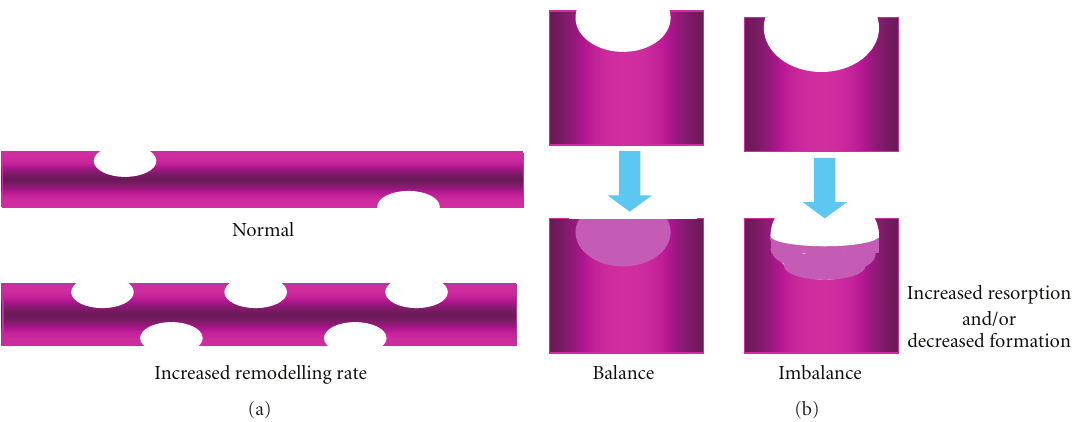
Figure 1: Mechanisms of trabecular bone loss. (a) Increased remodelling rate, (b) negative remodelling imbalance.